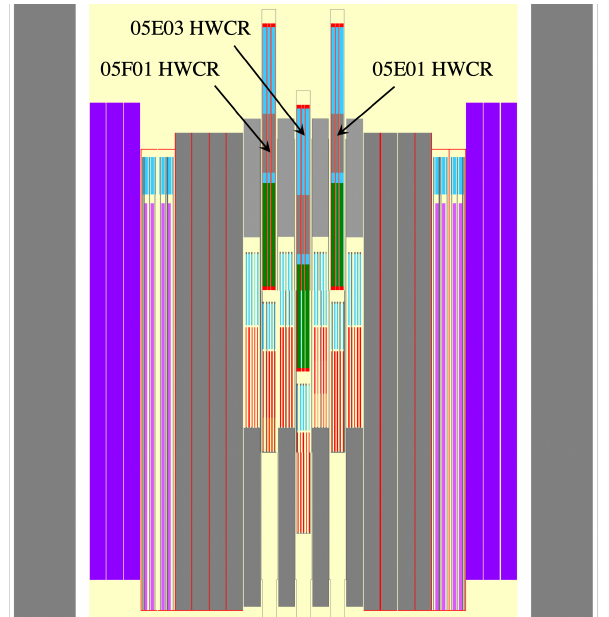
Figure 5. Axial view of the EBR-II SCALE full core model, highlighting the different insertion heights of three half worth control rod (HWCR)